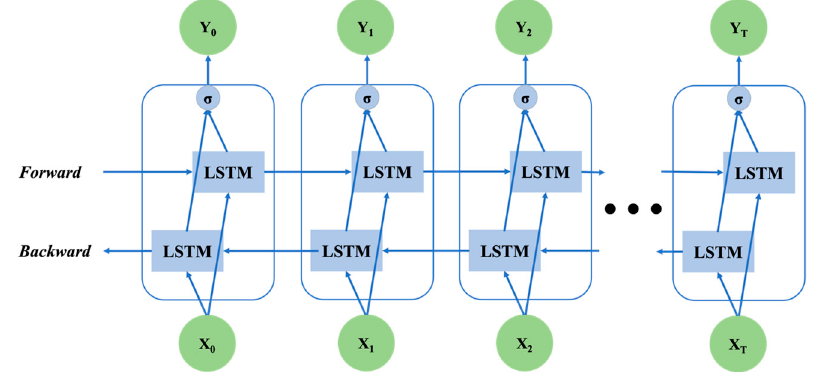
Figure 8. Bi ‐ LSTM structure, which combines forward LSTM and backward